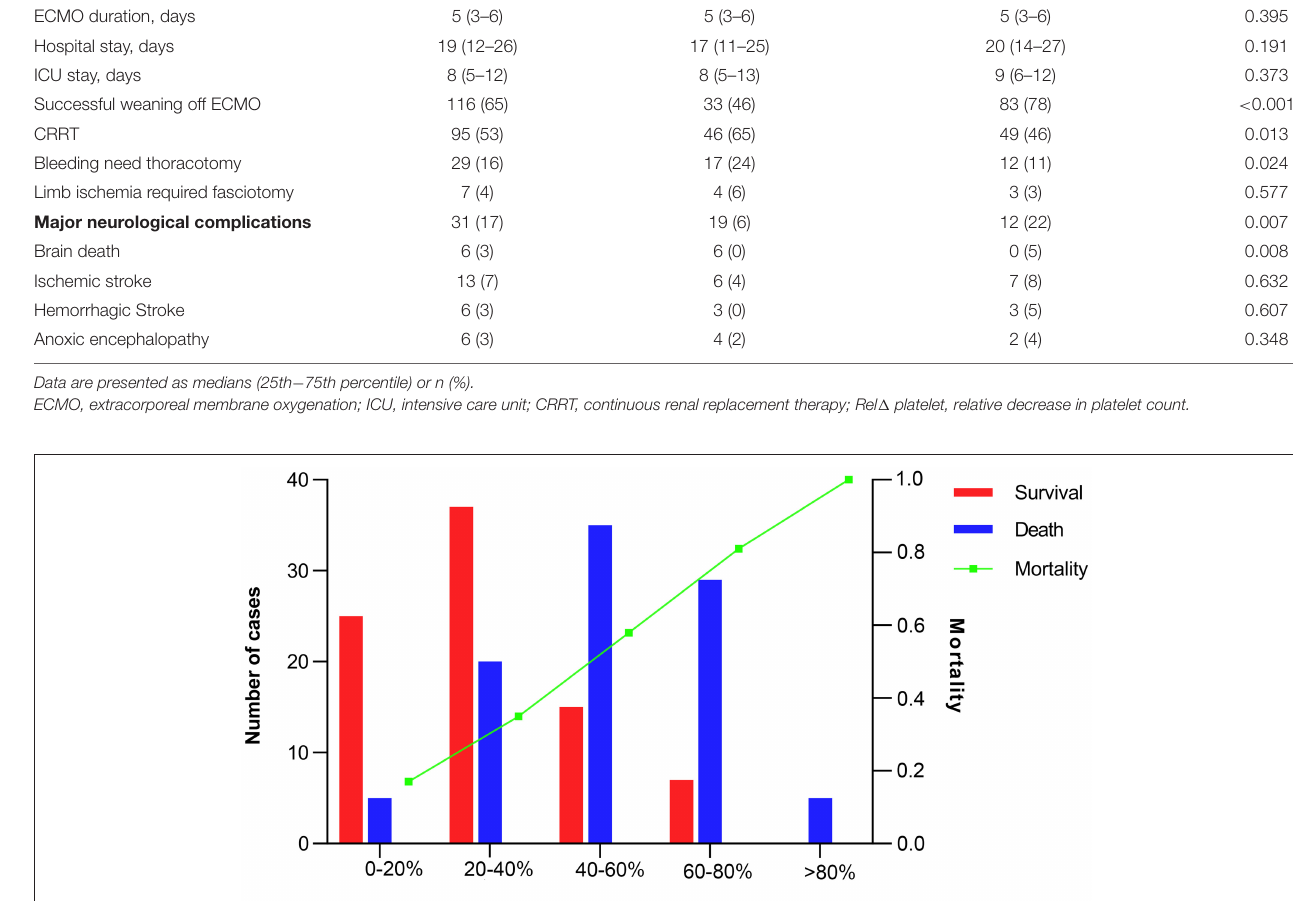
that seen in systemic inflammatory response syndrome